Question: What kind of plot is shown here?
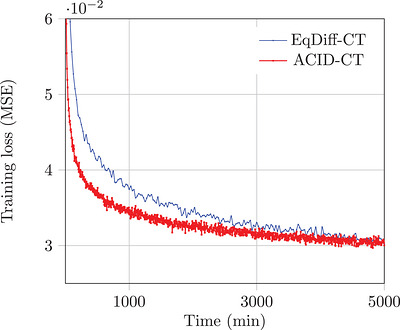
Answer: line